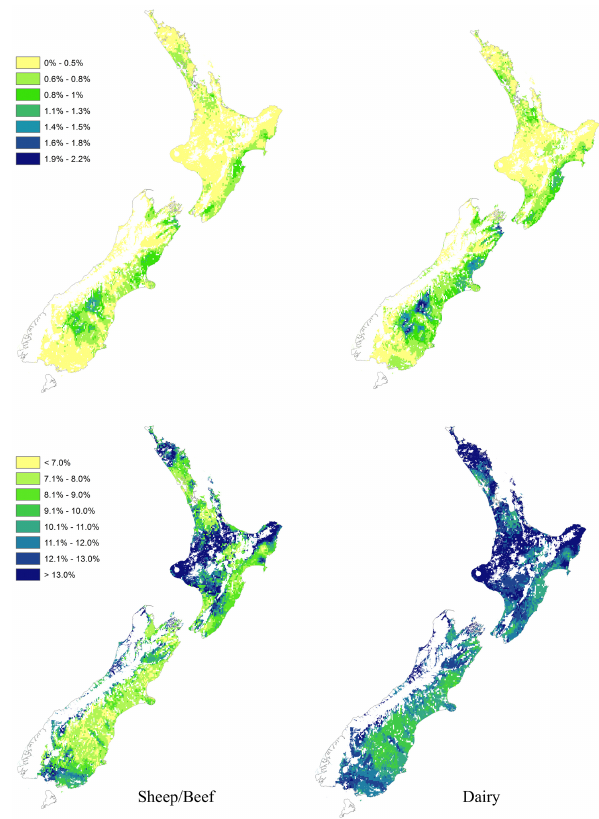
Figure 7. Elevated CO 2 (top) and intensification (bottom) 2020 model scenarios, average annual total pasture production, percent- age change from baseline for sheep/beef (left) and dairy (right). Each map shows national pasture production as if all of the avail- able land (excluding urban and conservation land) were devoted to sheep/beef or dairy agriculture systems and is not an actual repre- sentation of current or projected land